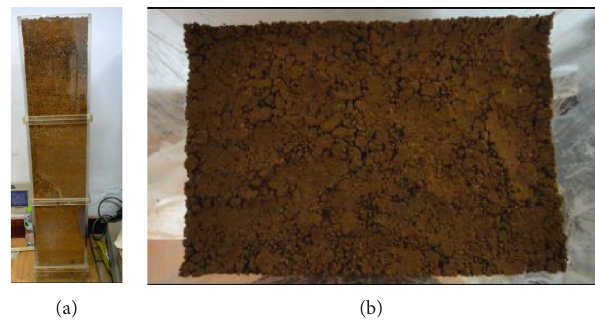
Figure 1: Photos of the soil column: (a) side view of the soil column; (b) plan view from the top of the soil